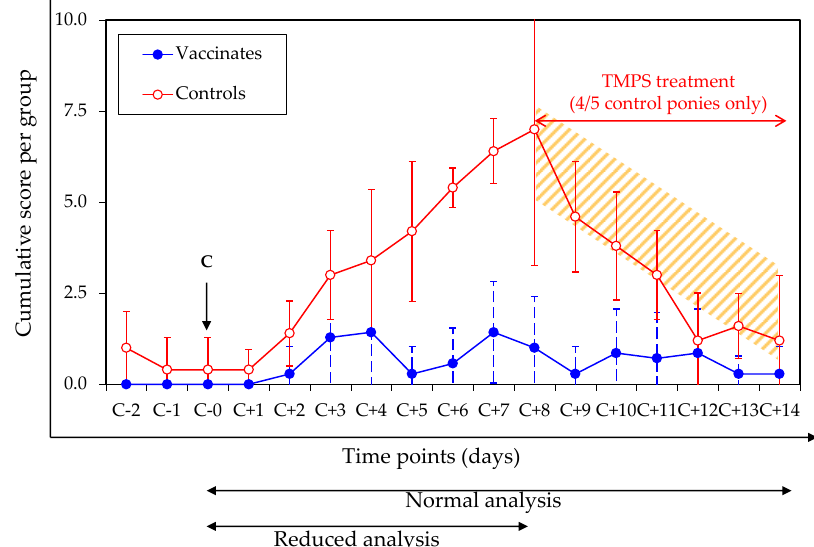
Figure 3. Cumulative clinical signs of disease. The day of infection (C; Day 186 = C-0) is indicated with an arrow. Closed circles = vaccinated ponies; open circles = control ponies. The period of antibiotic treatment (trimethoprim/sulfadiazine, TMPS) is represented as a shaded area. The time periods considered for the normal and the reduced analyses are also indicated.